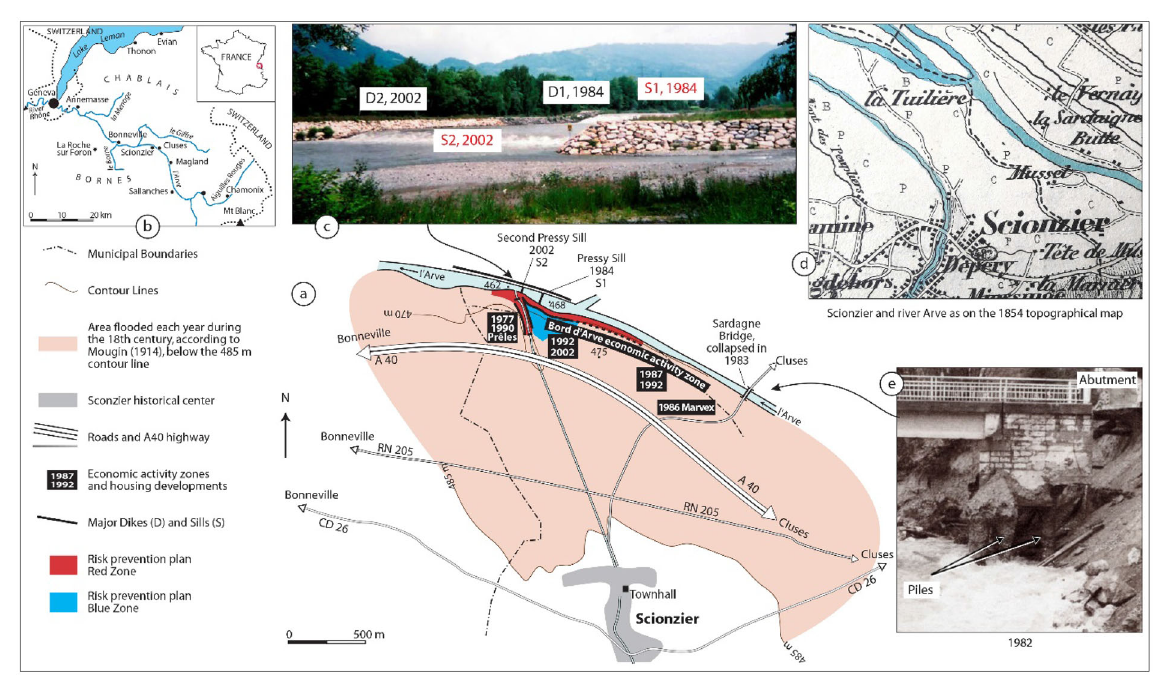
(‘‘de´partementales’’ archives of Haute-Savoie), reference 1 FI 417 for the topographical map of Bonneville, 1854; reference 2478 W 173 for the picture of Sardagne bridge linked with a map at scale 1/2000, 1983